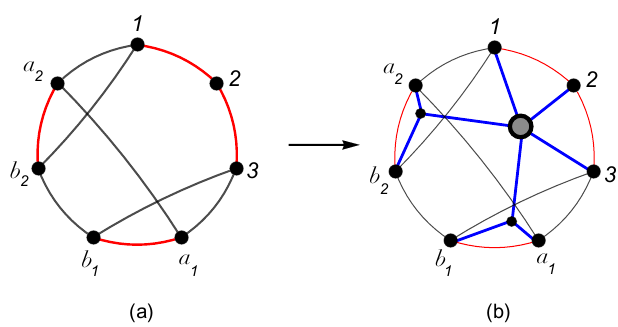
Figure 6 . (a) CHY-graph for the (cid:12)rst term in (4.12) . (b) All trivalent Feynman diagrams associ- ated to the CHY-graph (The grey circle means the sum over all possible trivalent vertices.).